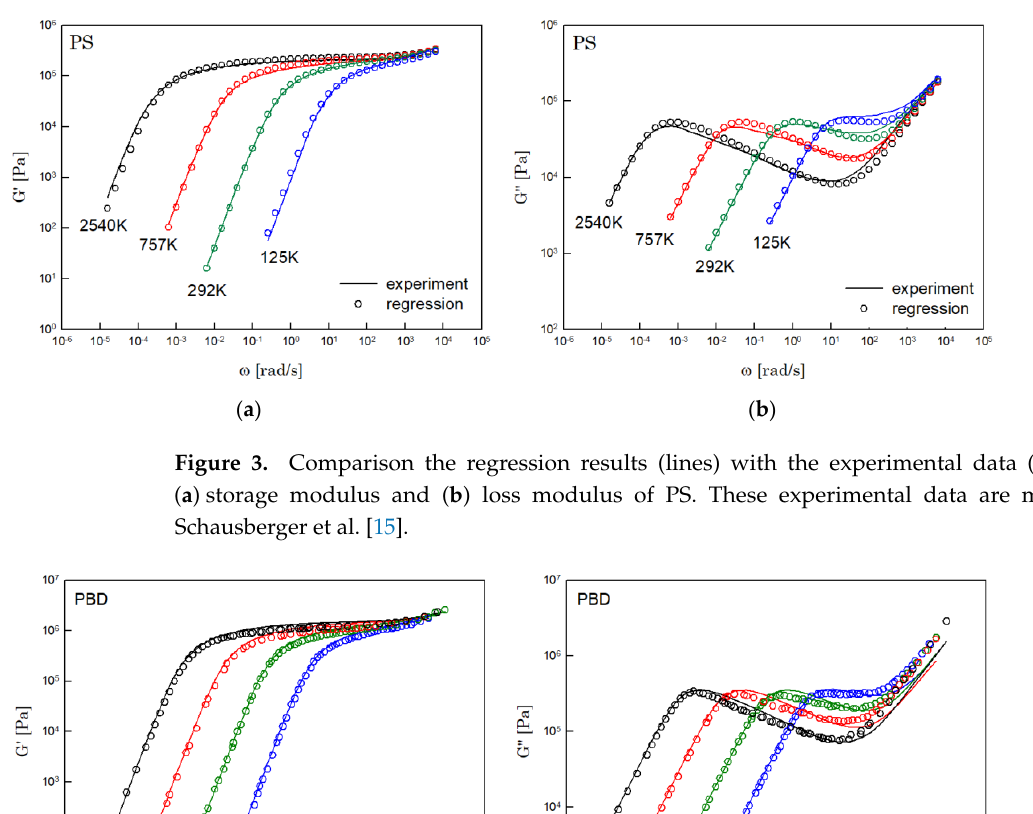
( b ) Figure 5. Comparison the regression results (lines) with the experimental data (symbols) of ( a ) stor- age modulus and ( b ) loss modulus of PI. These experimental data are measured by Person et al. [17].